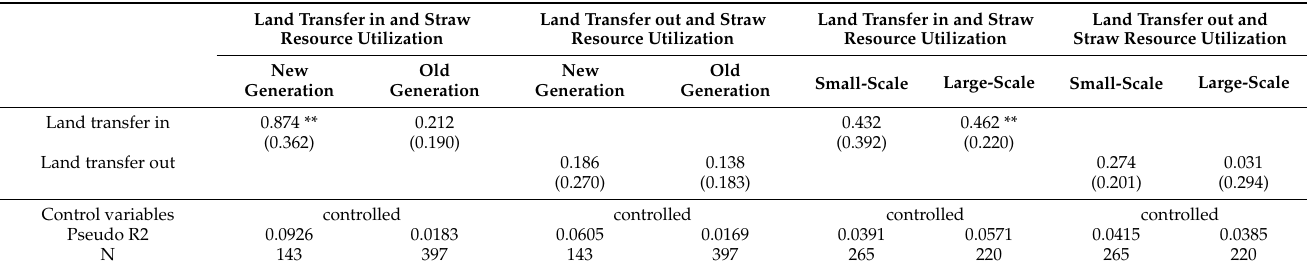
Table 5. Heterogeneity